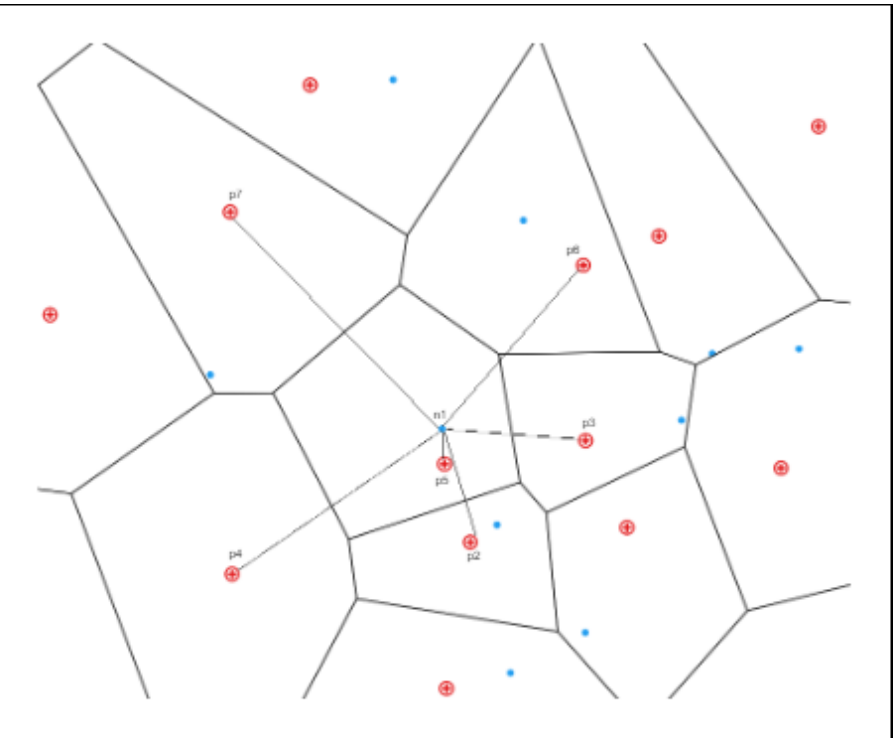
Figure 5. Example of the nearest POIs (EMS) from n 1